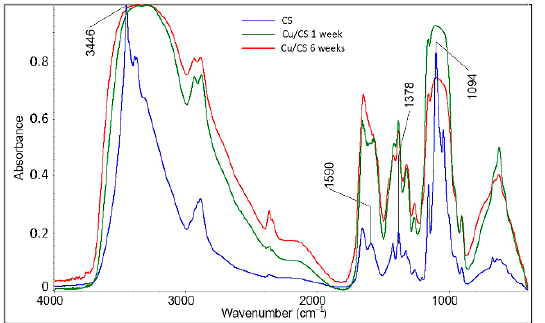
Figure 5. FTIR spectra of Cu/CS air-dried thin films (low molecular weight chitosan, molar ratio Cu/CS = 1/10) with different exposure times.